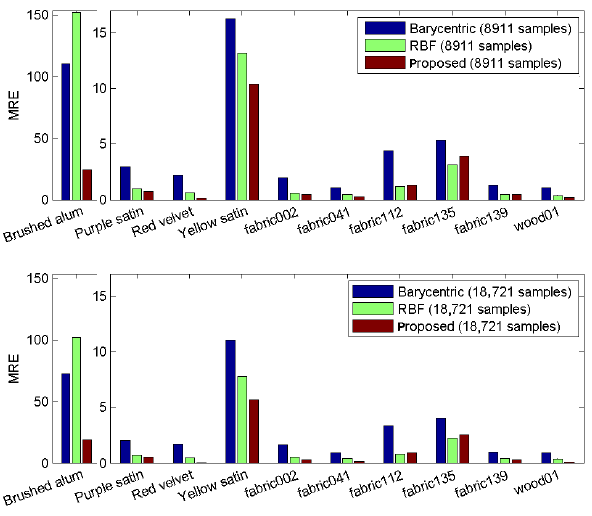
Fig. 9 MRE of the proposed method, barycentric interpolation, and RBF interpolation. Top: for sampling scheme 14 (8911 samples). Bottom: for sampling scheme 19 (18,721